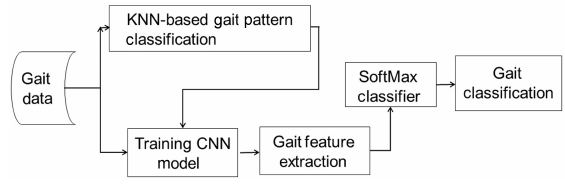
Fig. 6 Gait feature fusion-based identity-recognition